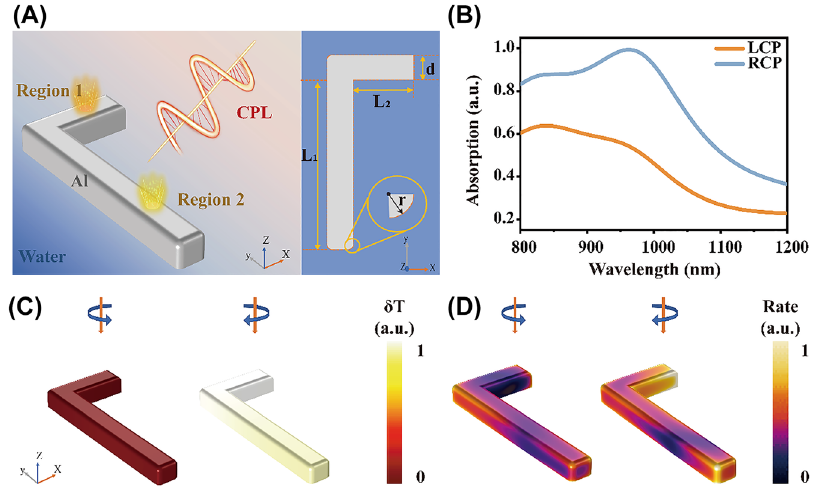
Figure 1: Optical properties of the single LCN of an array. (A) Schematic of the chiral effect and shape parameters of the LCN.